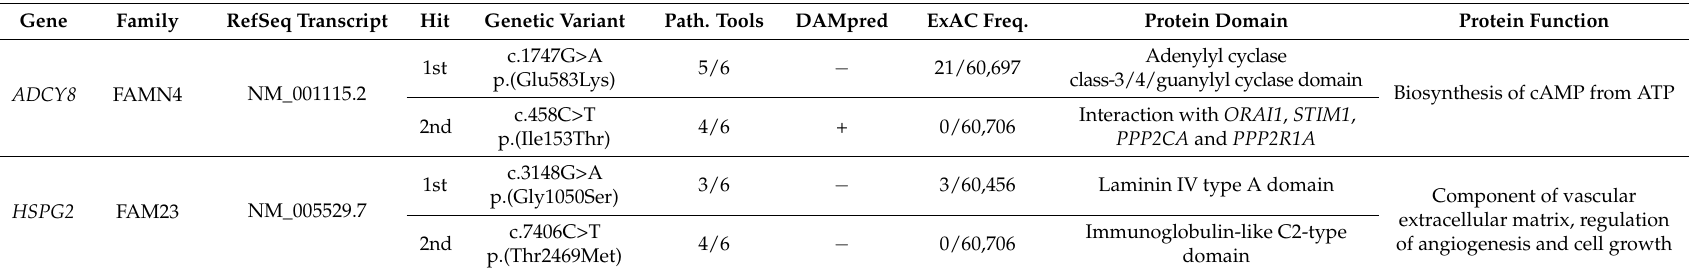
Table 1. Description of the genes carrying a potentially disruptive germline SNV (single nucleotide variant) and a different SNV in the matched-tumor